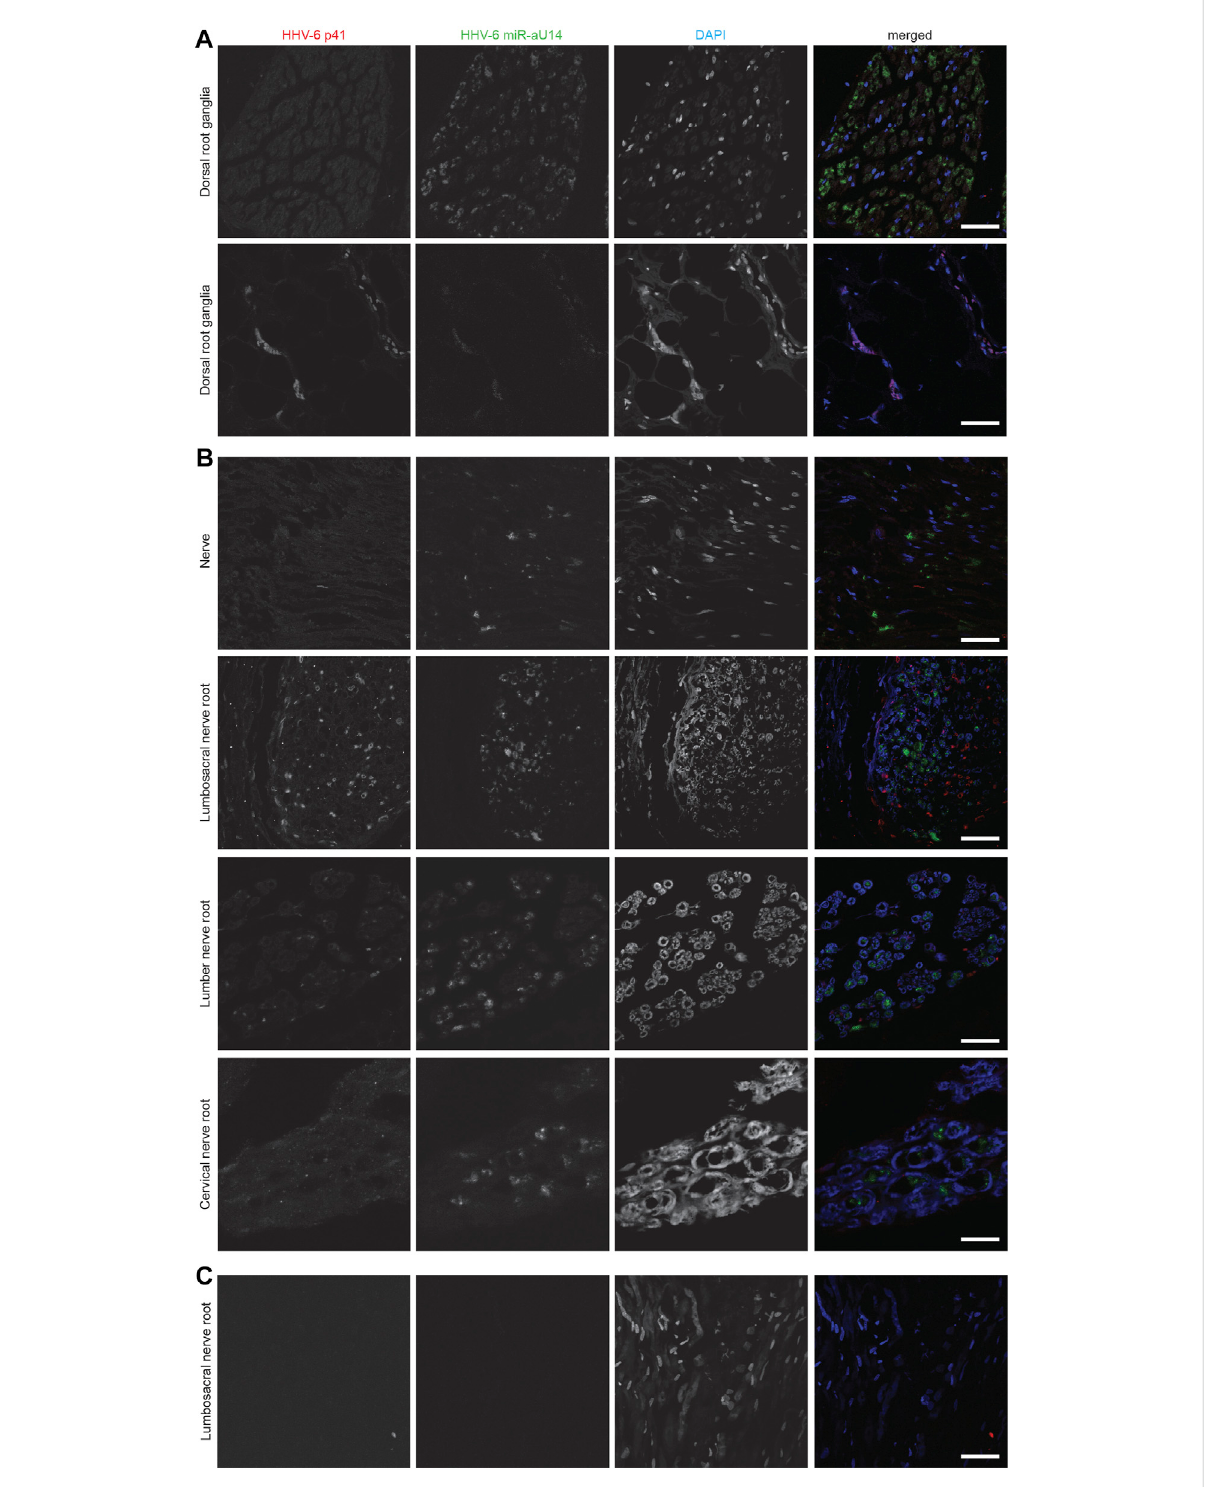
FIGURE 2 Representative fl uorescence microscopy images of different human neuronal tissue types from two different ME/CFS patients and a control individual.ForeachpanelimagesfromthelefttotherightshowHHV-6p41(red),amarkerforactiveHHV-6Ainfection,miR-aU14(green),cellnuclei stained with DAPI (blue) and an overlay of the images. (A) Human Dorsal root ganglia tissues of a ME/CFS patient. (B) Nerve, Lumbosacral nerve root, lumber nerve root and cervical nerve root tissues of a ME/CFS patient. (C) Lumbosacral nerve root tissue of a ME/CFS patient. The scale bars represent 100 μ